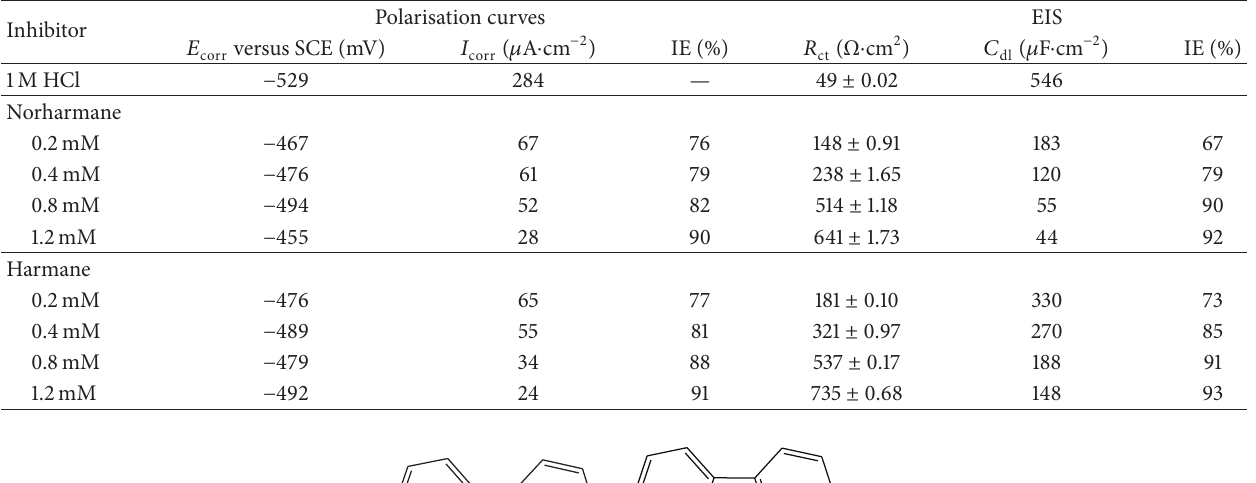
Table 1: Corrosion parameters obtained from electrochemical measurements of C38 steel in 1M HCl containing various concentrations of indole derivates at 25 ∘ C.